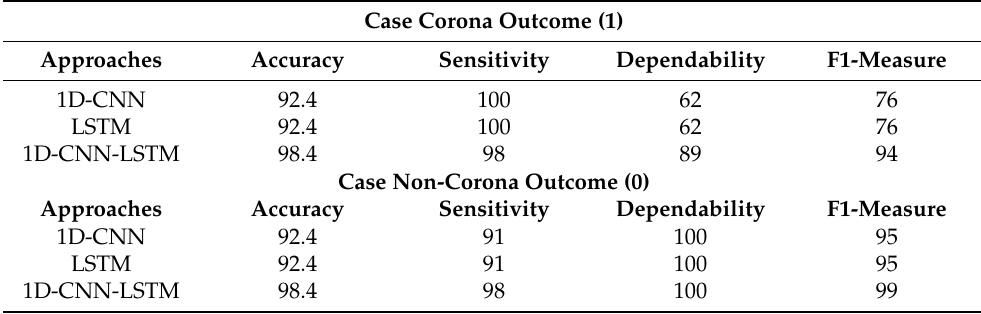
Table 13. The assessment of various metrics in accordance with the DL structure’s testing-phase performance results for the time